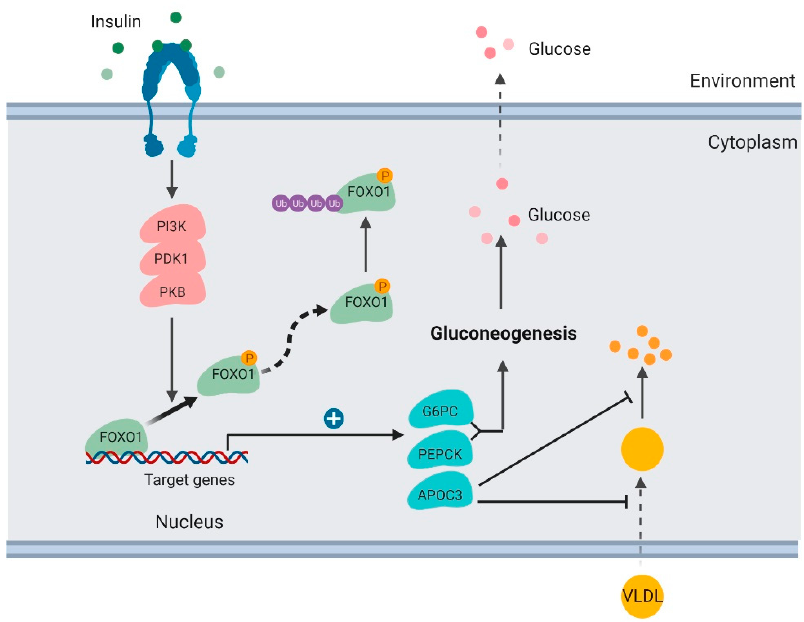
Figure 2. Regulation of glucose production and lipoprotein uptake by FOXO1 in the liver (created with BioRender.com).